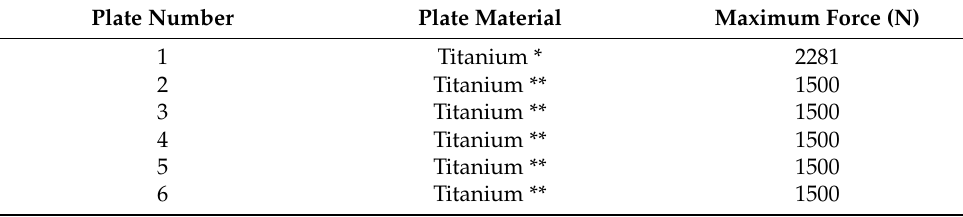
Table 3. Results of the load to failure test. N/A: Plate broke in fatigue